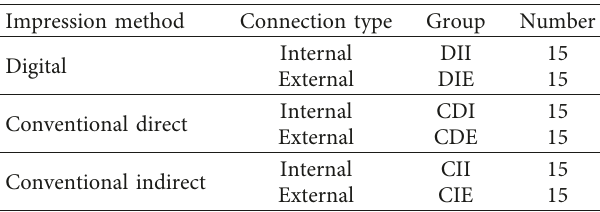
Table 1: Definition of